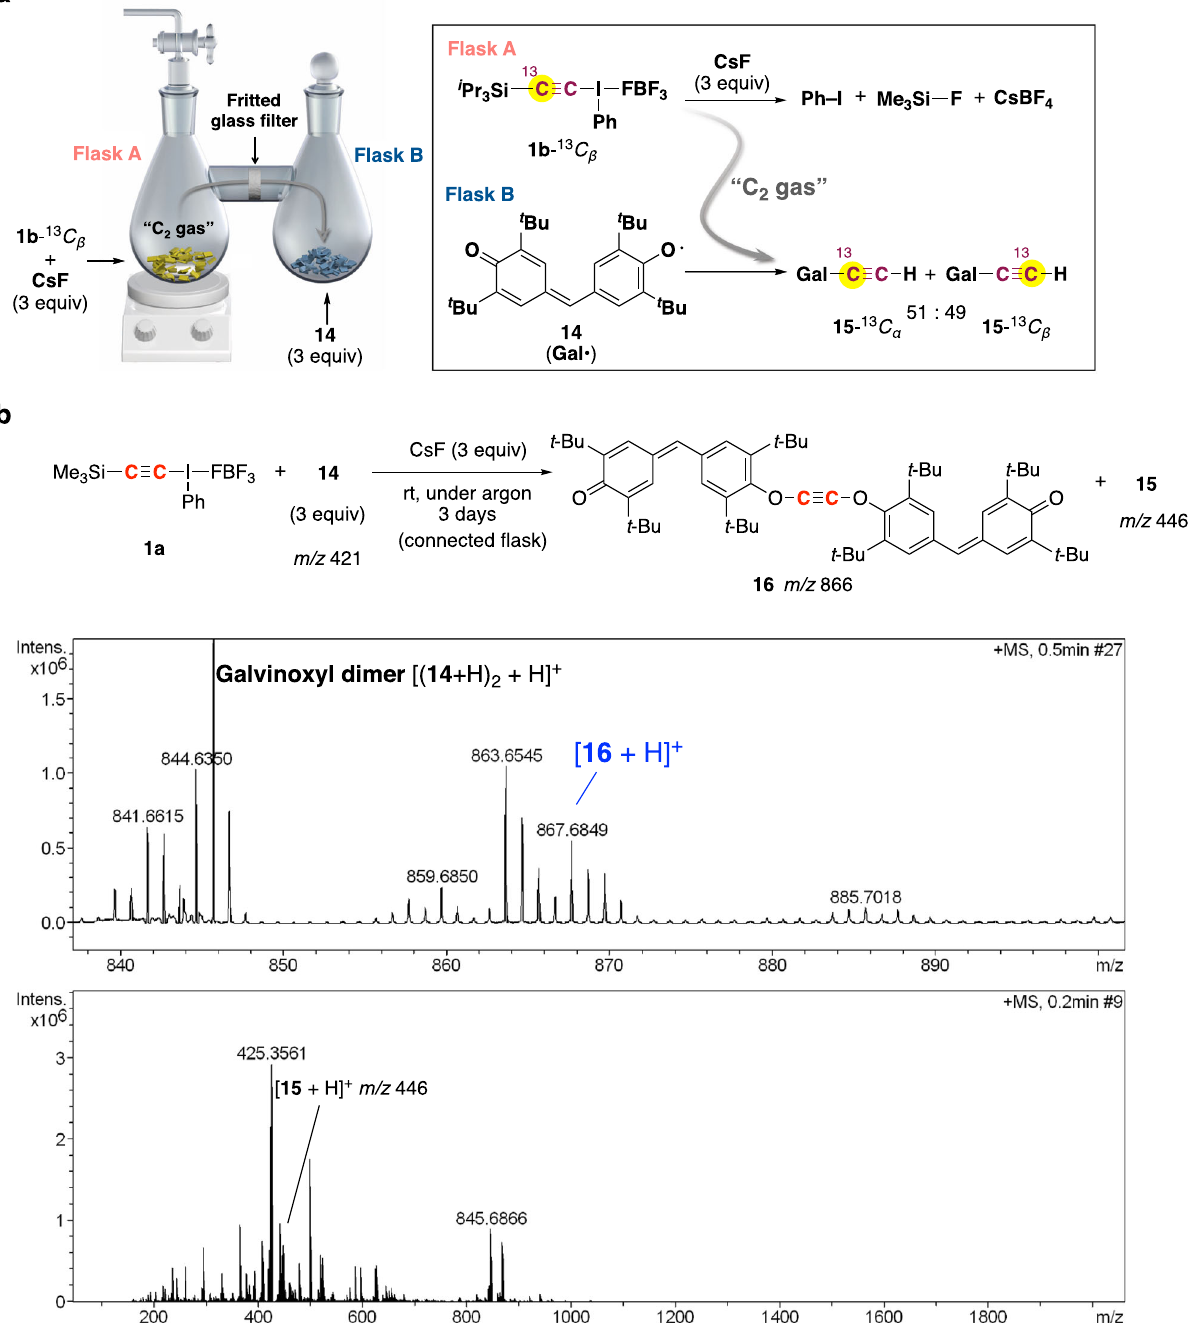
Fig. 1 Connected- fl ask, solvent-free experiment. a 13 C-labeling experiment. b APCI mass spectrum (positive ion mode) obtained from the contents in Flask